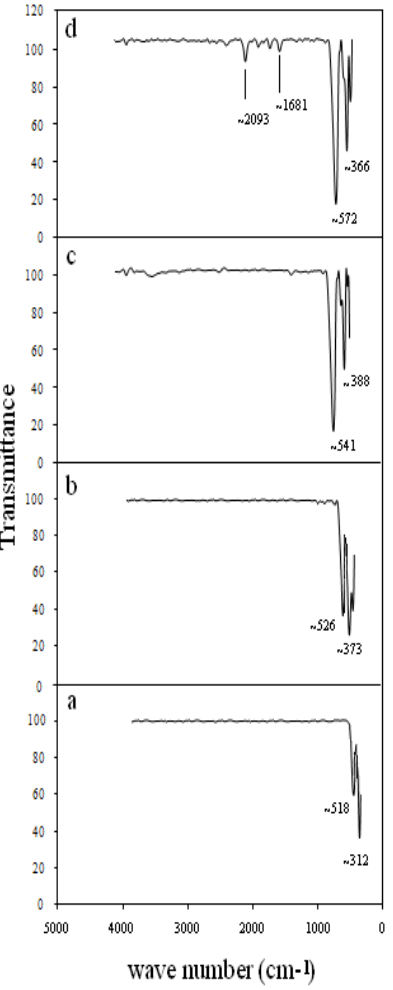
Figure 5. FT-IR spectra of zinc ferrite nanoparticles with concentrations of ( a ) 0, ( b ) 15, ( c ) 40, and ( d ) 55 g/L, which calcined at 873